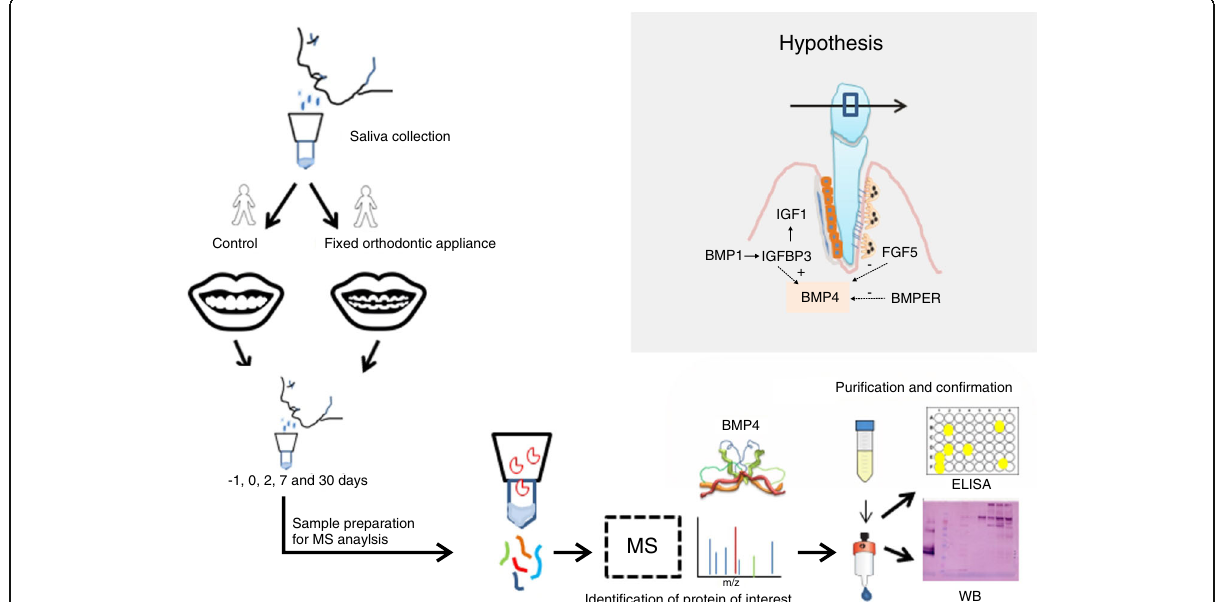
Fig. 1 Graphical summary of the conducted pilot study, including the presented